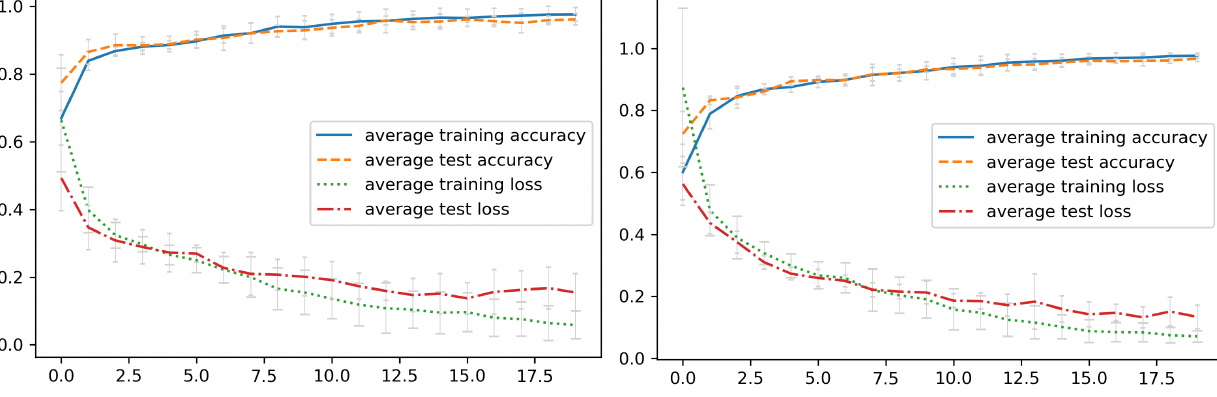
Figure 11. Left image: single dropout. Right image: double dropout. Summary of average results for 20 iterations. Class 0 vs. III. Model: the LeNet model from Figure 5 was applied. Cross-validation 5. Accuracy for 20 iterations of neural network training and corresponding cross-entropy